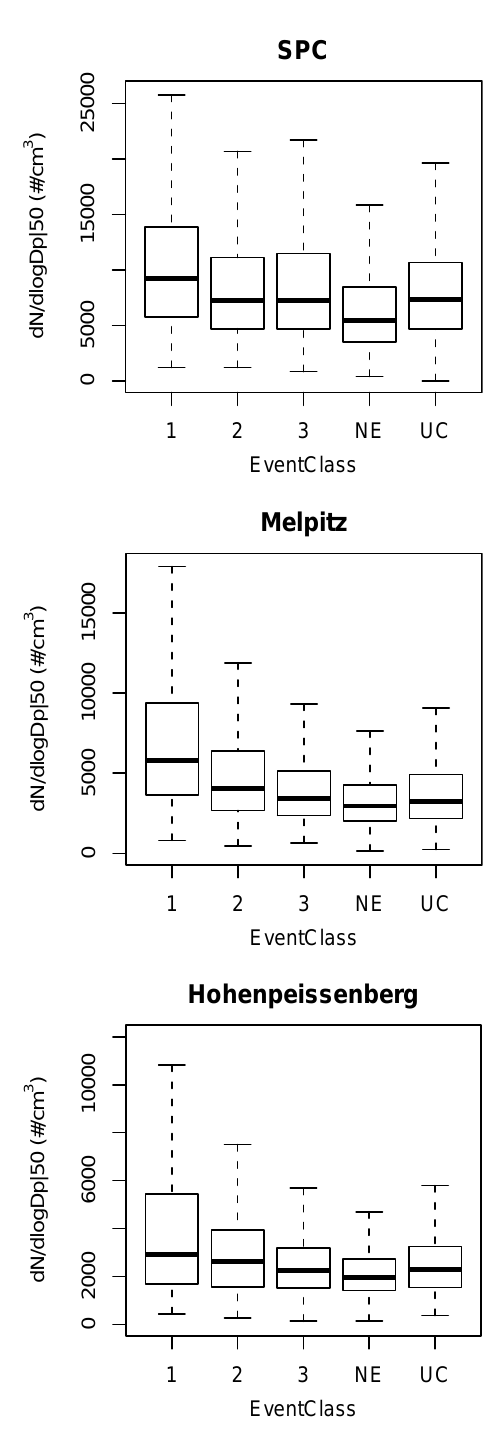
Fig. 1. Experimental particle concentrations at 50nm ( dN/d log D p ) for different event classes. The box plots indicate the median (bar), 25th and 75th percentiles (box), and the minimum and maximum values (whiskers) that were not considered outliers. “1”, “2”, and “3” indicate NPF event classes of decreasing intensity (see text). NE: non-events, and UC: unclassified (i.e. ambiguous)